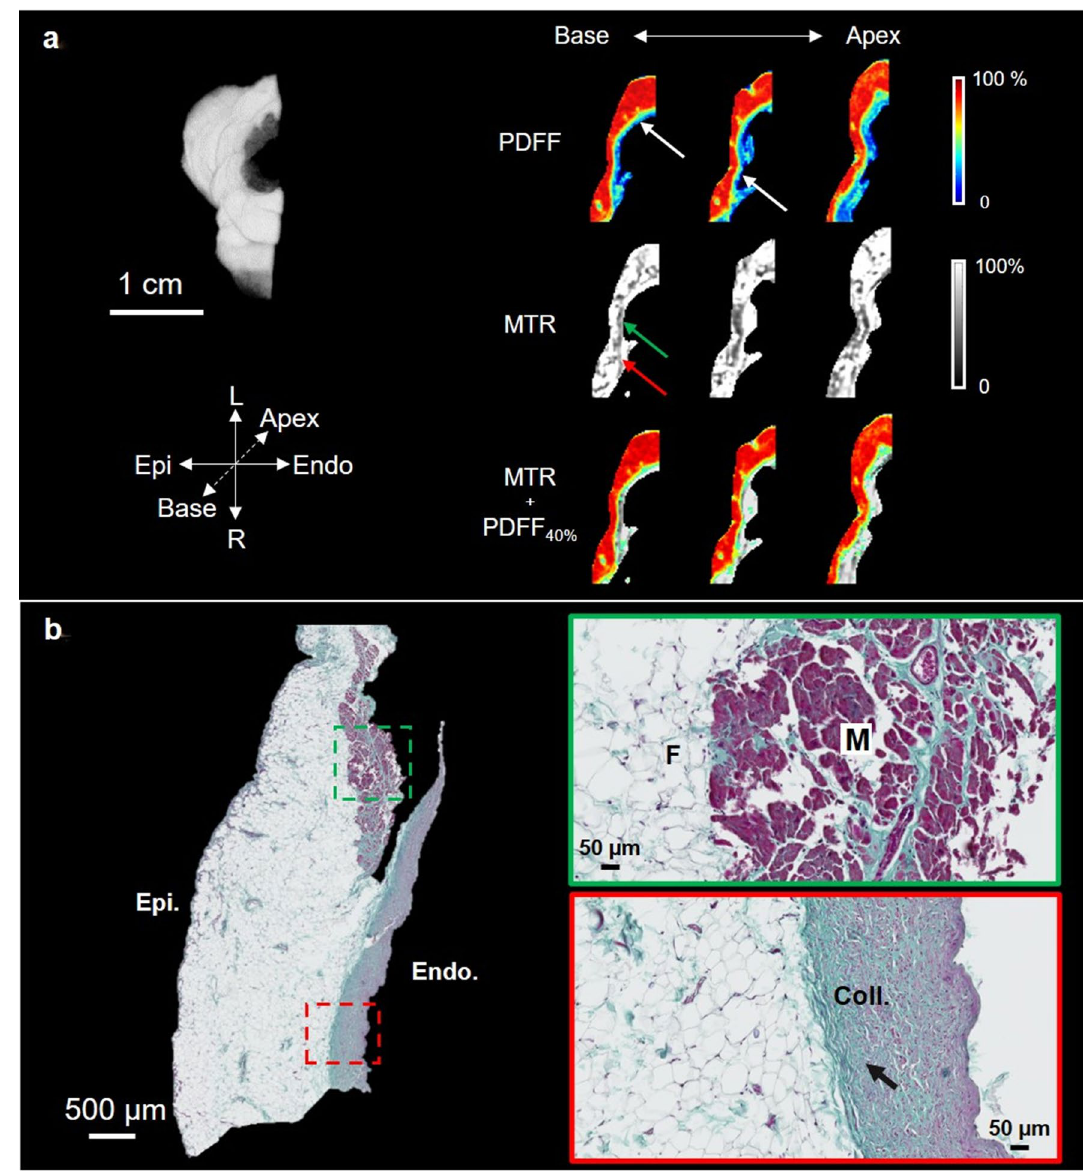
Figure 5. RVOT subsample of the ARVC heart. Axial view ( a ) of the RVOT cut sample (1.4 × 1 × 0.6 cm 3 ). PDFF with epicardial fat contact to the myocardium (white arrows), MT ratio (MTR) and MTR with fat > 40% (MTR + PDFF 40% ) overlaid are presented. All the MRI slices are 200 µm thick and separated by 1 mm. Corresponding histological slices ( b ) stained with Masson’s trichrome are also shown and zoomed regions (green and red dashed rectangles) are displayed. Muscle (M), fat (F) and collagen (Coll.) are visible. The myocardium is filled with collagen (black Table 1 provides quantitative estimates of fat and tissue contents in ARVC and healthy hearts for the whole hearts and for the three regions of interest of the “ARVC triangle” (Figs. 5–7) through MRI and histological data analysis. Both hearts had similar volumes (339 cm 3 vs. 306.6 cm 3 ), but with different fat ratios (36.0% vs. 17.2%). Fat ratios according to the MRI data in the RVOT, RV free wall and RV apex septum for the ARVC and healthy hearts were 76.0% vs. 31.9%, 66.5% vs. 28.7% and 4.5% vs. 1.3%, respectively. The histological analysis of the fat ratios in the three regions led to 79.6 ± 9.6% vs. 39.2 ± 6.3%, 61 ± 5.6% vs. 28.8 ± 7.2% and 7.2 ± 3.8 vs. 5.7 ± 2.5% for the ARVC and healthy hearts, respectively.